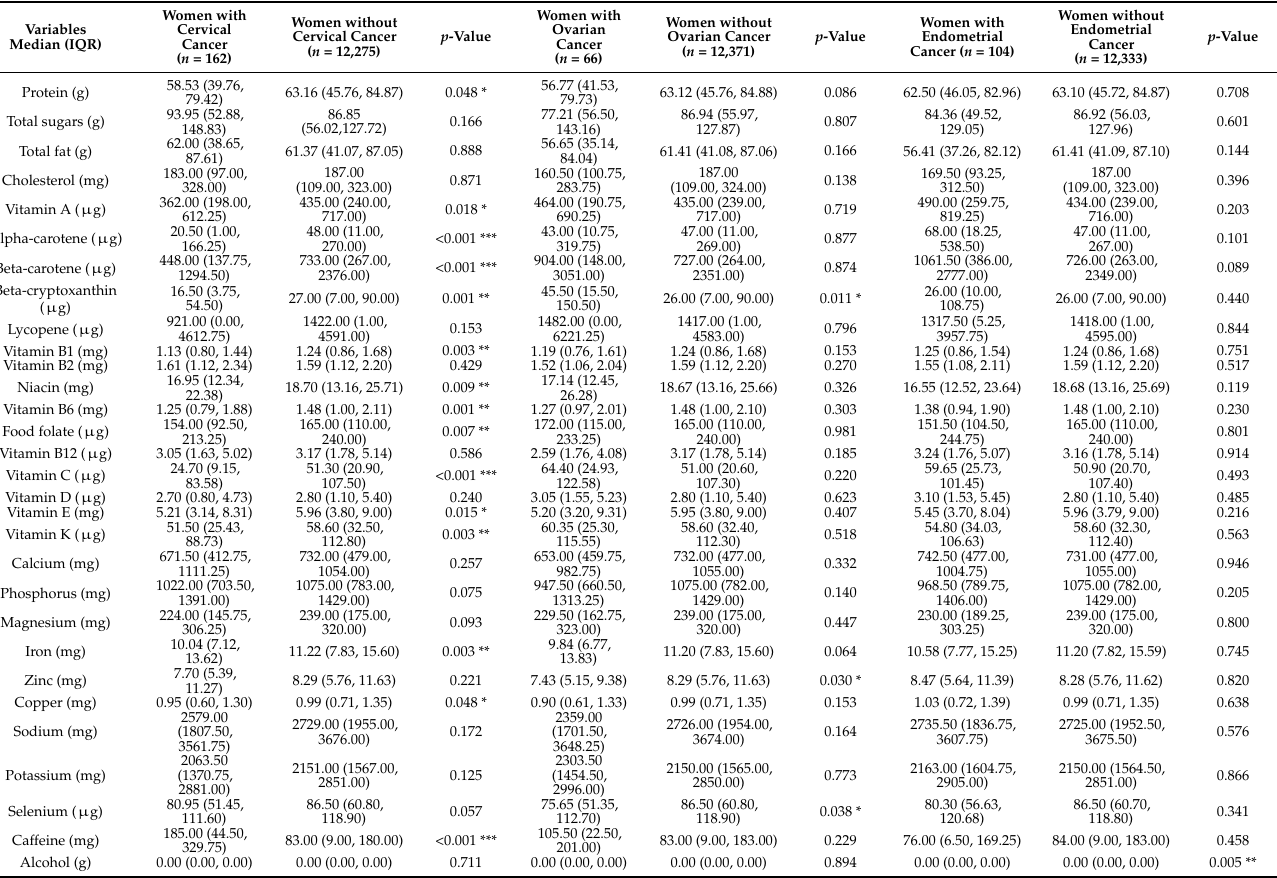
Table 2. Dietary intakes in women with and without self-reported cervical cancer, ovarian cancer and endometrial cancer,